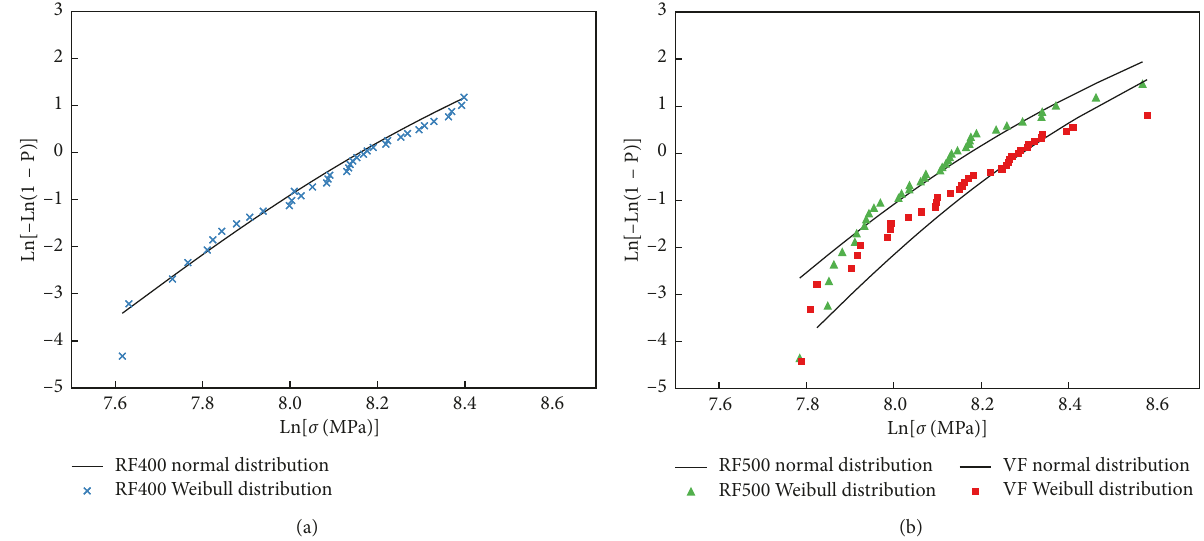
Figure 6: Comparison of Weibull plot and normal distribution of stress to failure of RF400, RF500, and VF fibres (log-log plots). 246810